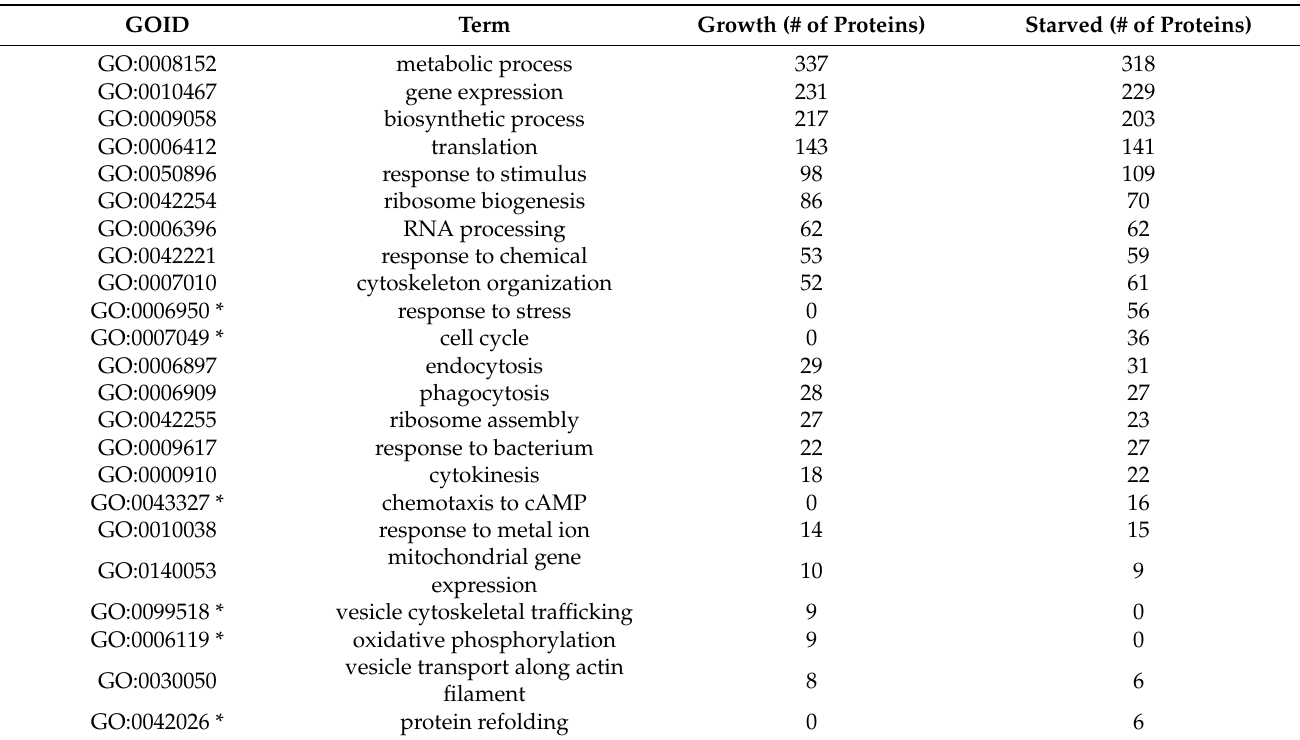
Table 3. Gene ontology (GO) term enrichment analysis summary (biological process) for proteins identified in calmodulin (CaM) immunoprecipitation (IP) fractions. Displaying only those results with p < 0.05.